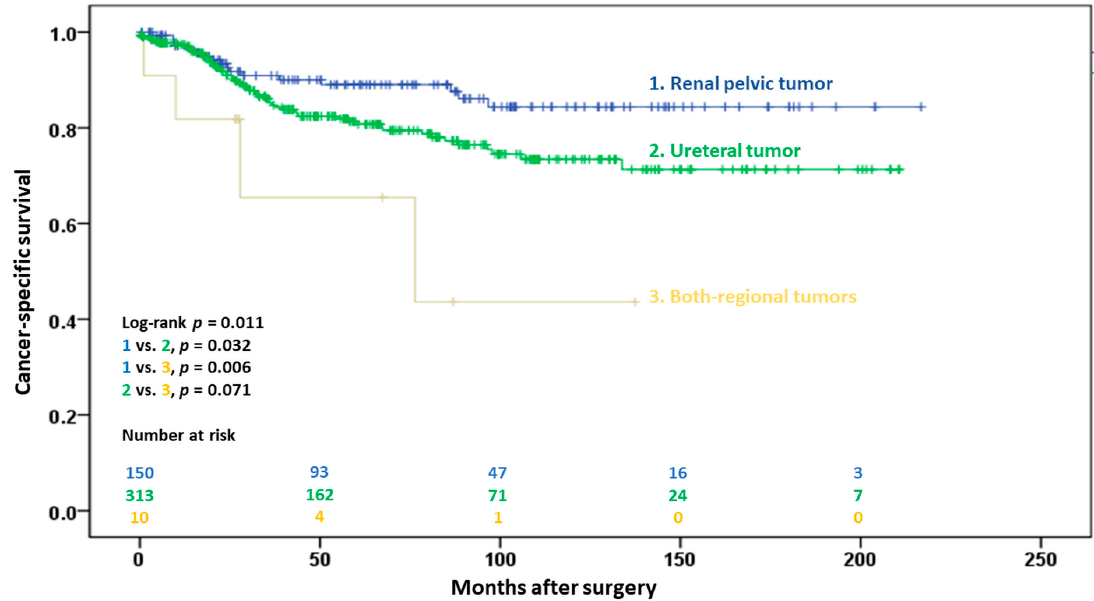
Figure 3. Kaplan–Meier estimates of cancer-specific survival in 476 patients following radical surgery for pT2 upper urinary tract urothelial carcinoma, with stratification by tumor location. Table 3. Univariate and multivariate analysis predicting prognostic factors for cancer-specific sur- vival in the patients with pT2 UTUC after radical surgery.